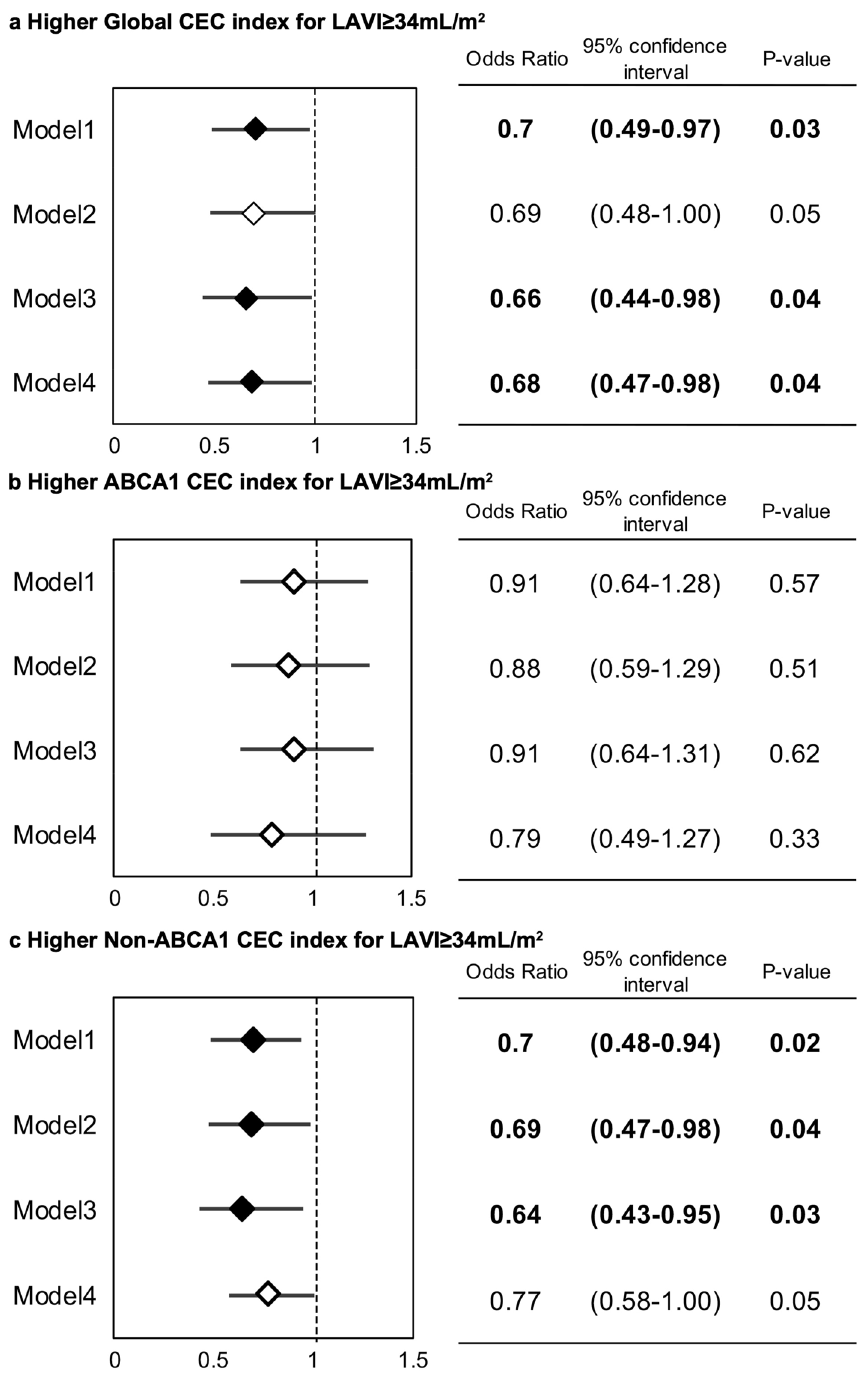
Figure 4. Odds ratios of 1 standard deviation (1SD) higher Global, ABCA1, and Non-ABCA1 cholesterol efflux capacity (CEC) indexes for an enlarged left atrium. Adjusted multivariate logistic regression analyses using 3 models assessed the odds ratios of 1SD higher of Global CEC (a), ABCA1 CEC (b) and Non-ABCA1 CEC (c) indexes and LAVI ≥ 34 mL/m 2 . Model 1 included age, male gender, hypertension, smoking history, and 1SD higher left ventricular ejection fraction (LVEF). Model 2 included the covariates of Model 1 and 1 higher logarithmic NT-proBNP (Log 10 NT-proBNP) instead of 1SD higher of LVEF. Model 3 included the serum level of high density lipoprotein cholesterol (HDL-C) and serum myeloperoxidase (MPO) in addition to those in Model 1. Model 4 included all previously established risk factors for the progression of the atrial structural remodeling in AF patients available in the present study, including age, male gender, hypertension, diabetes, smoking history, and biomarkers of heart failure (NT-proBNP), inflammation (hs-CRP) and obesity (BMI). Any CECs significantly associated with LAVI ≥ 34 mL/m 2 are shown as closed rhombuses, while open rhombuses are CECs without statistical